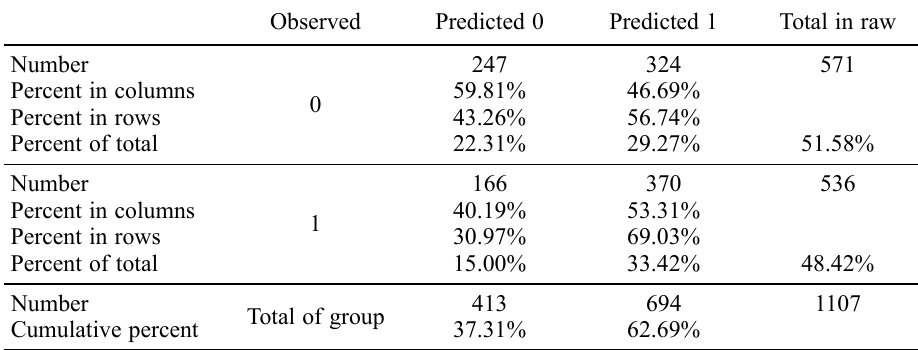
Table 6. Predictive value of regression